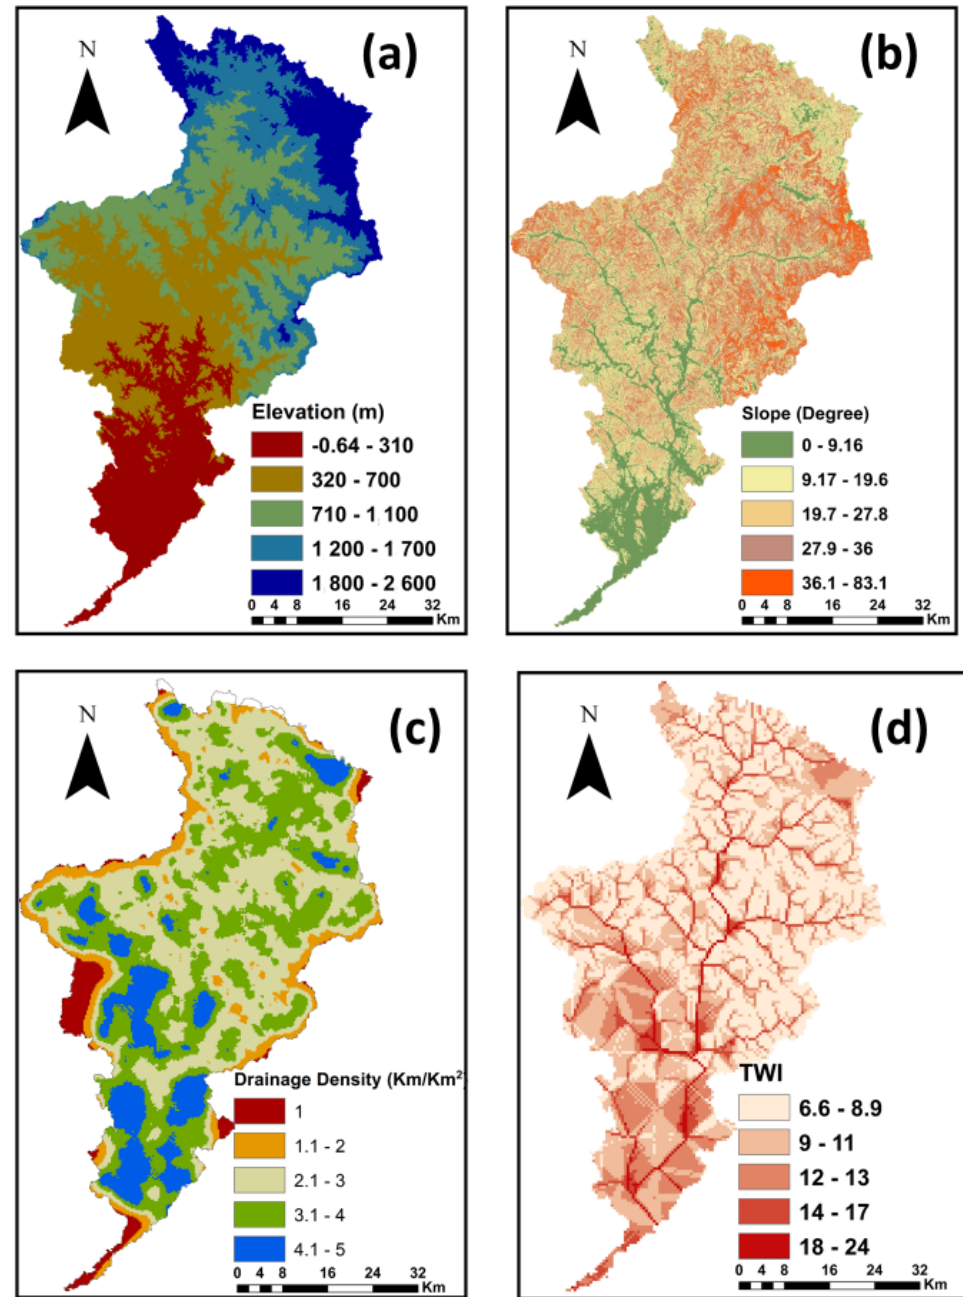
Figure 5. Flood hazard factors: ( a ) elevation; ( b ) slope; ( c ) drainage density; ( d ) topographic wetness index (TWI).